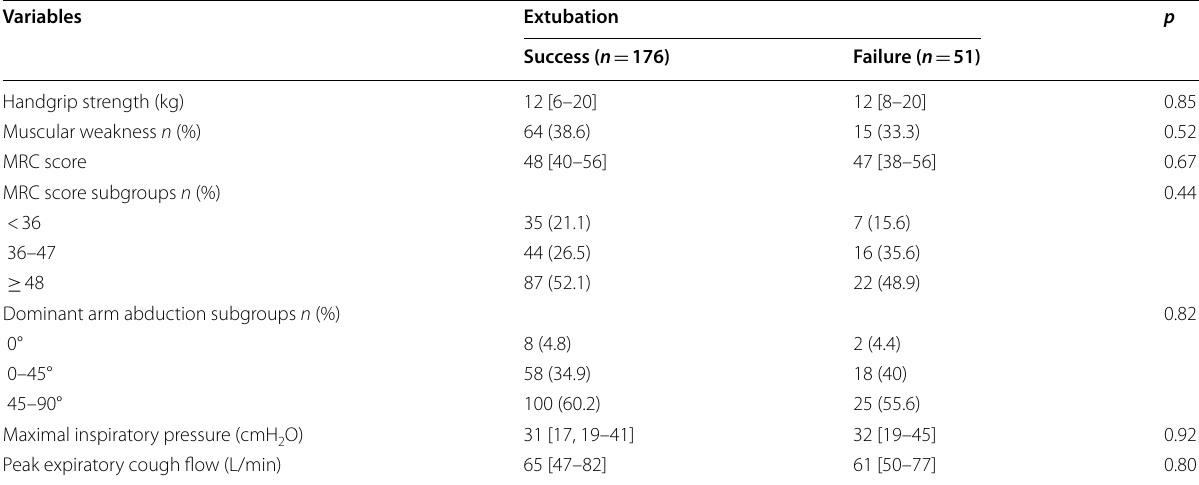
Missing data n 16 for handgrip, MRC score and dominant arm abduction ( n = inspiratory pressure abduction ( n 62 and n 20, respectively, in success and failure subgroups), n = = in success and failure subgroups)